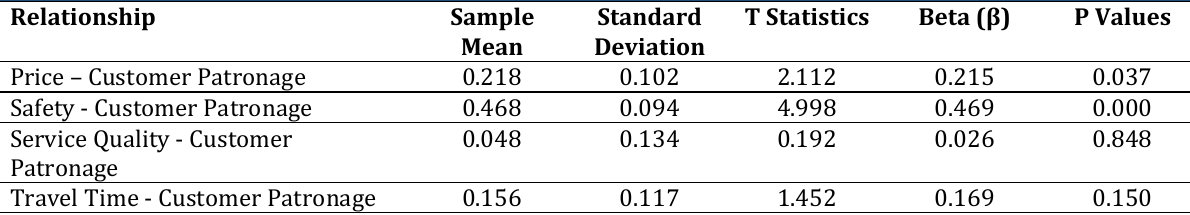
Table 3: Relationship model of railway commuting factors and customer patronage